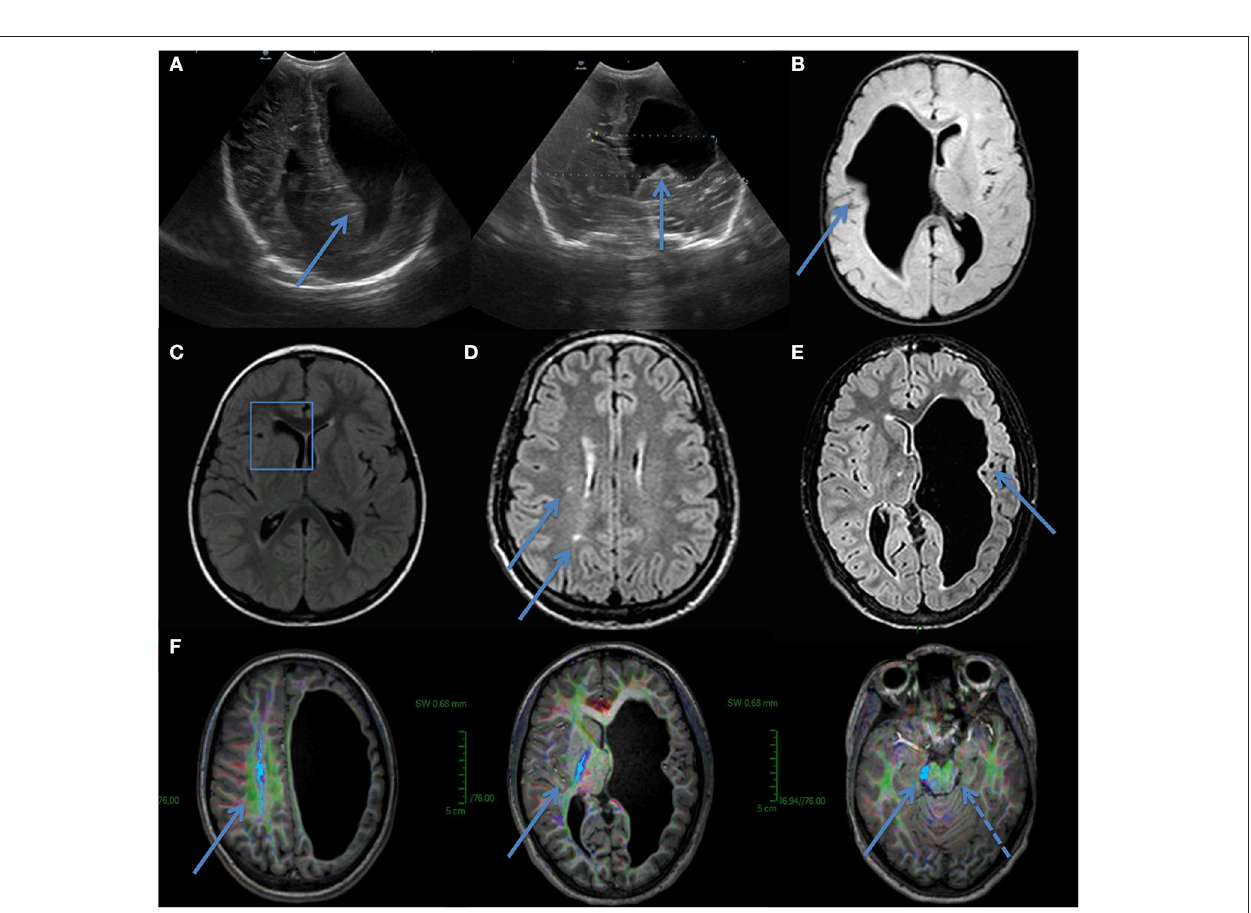
FIGURE 3 | Ultrasound in utero from IV-6 (A) . Image showed ventricular asymmetry and brain MRI confirmed right frontotemporal dilatation (B) . IV-5–Brain MRI revealing porencephalic cyst of frontal horn of lateral right ventricle (C) . (D) III- 3–Brain MRI showed small asymptomatic lesions in white matter. No microbleeds or cystic cavities were found. (E,F) IV-3–Brain MRI showed left frontotemporal dilatation and diffusion tensor imaging (DTI) sequences demonstrated no left corticospinal tract (cranio-caudal fibers, indigo, with arrows). A dashed arrow indicates secondary atrophy in the left cerebral peduncle.